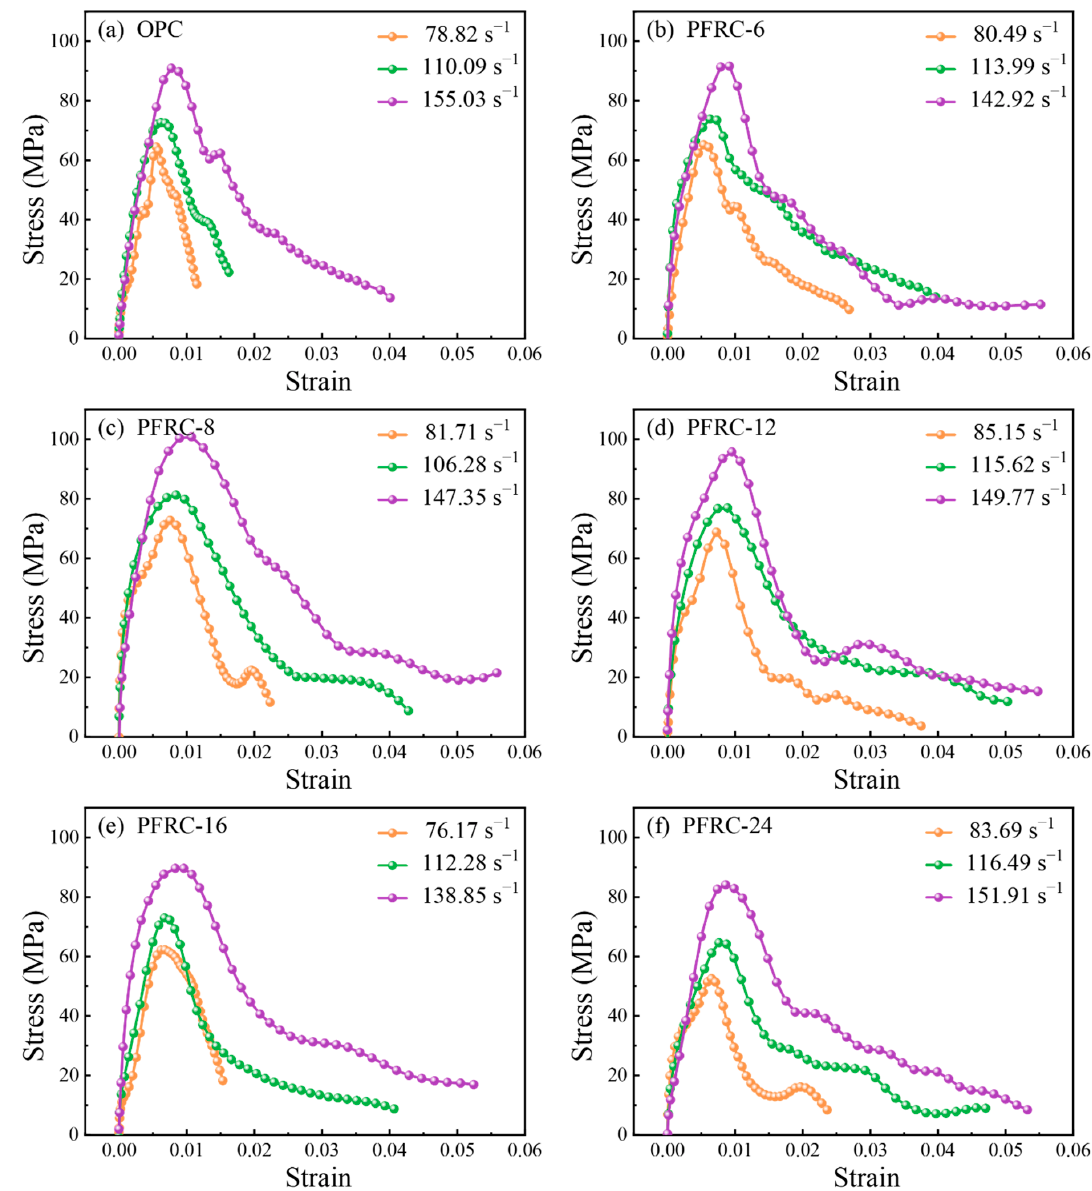
Figure 7. Stress–strain curves of specimens at different strain rates: ( a ) OPC; ( b ) PFRC-6; ( c ) PFRC-8; ( d ) PFRC-12; ( e ) PFRC-16; and ( f ) PFRC-24.